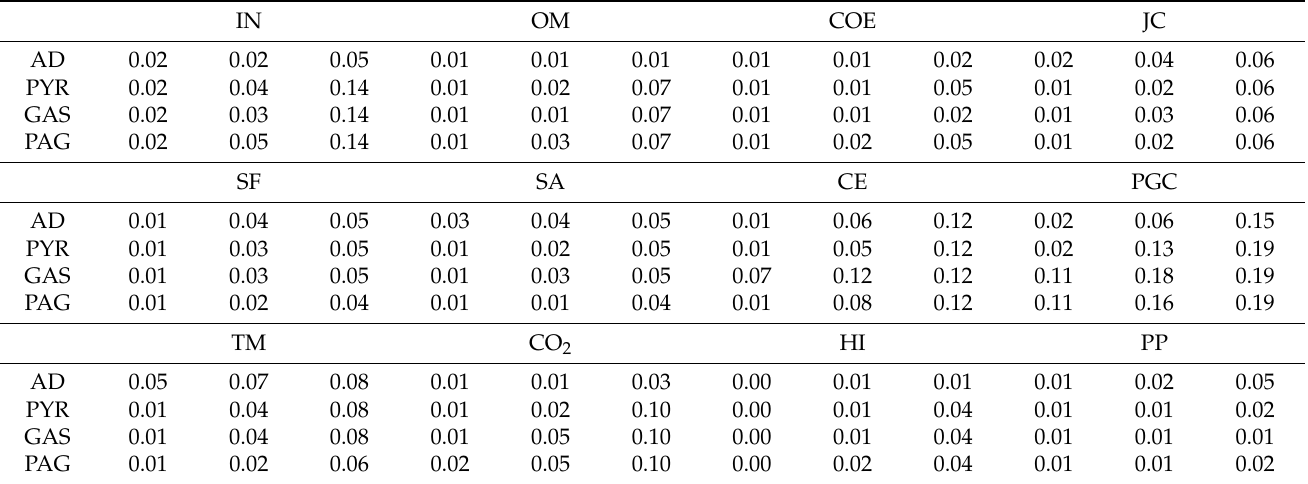
Table 8. Weighted normalized fuzzy decision matrix.